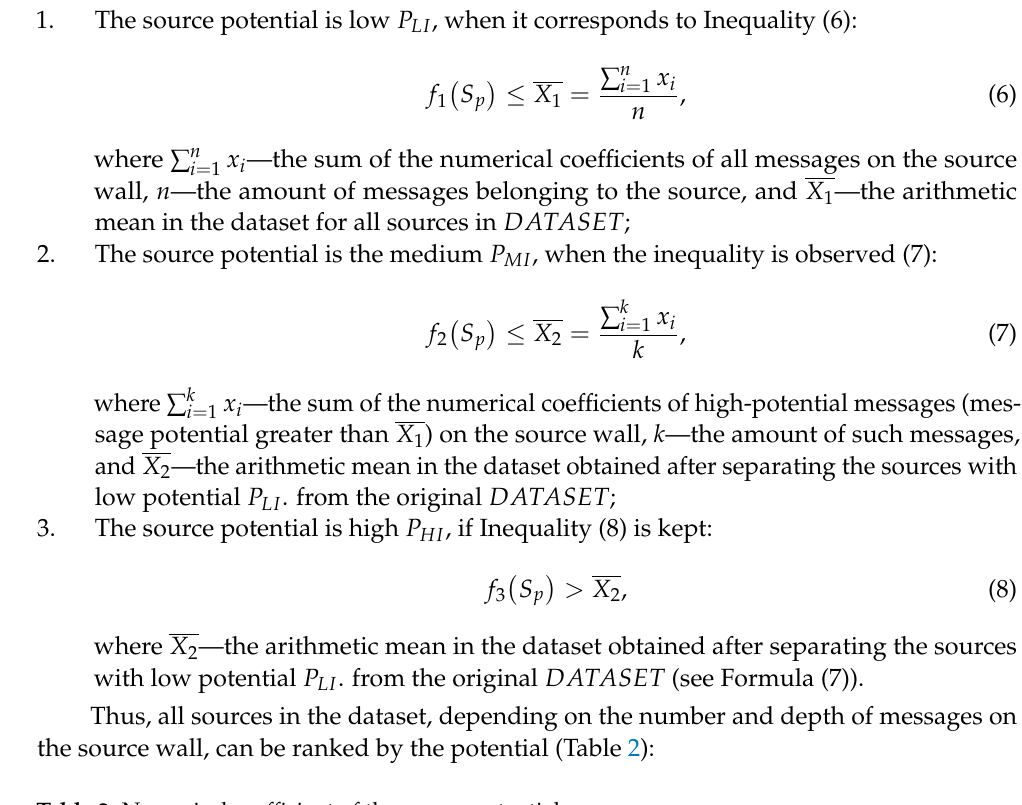
Table 2. Numerical coefficient of the source